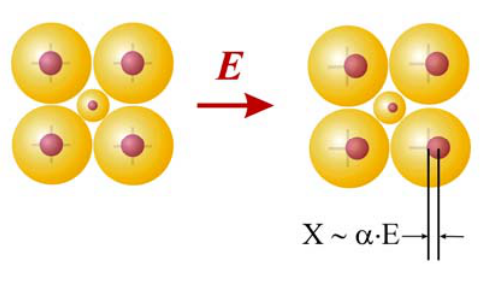
Figure 4 The shift of the nuclei relative to the electron clouds by an external electric field E (image from [38], reproduced by permission of The Royal Society of Chemistry). The radius of the clouds indicates the size of the polarizability. The external field induces a small change in the value of the electronic polarizability volumes, but this effect is neglected. Furthermore, in the hard-spheres approximation, the electronic clouds of different atoms are not free to move relative to each other. In a classical picture at optical frequencies, the atom’s nucleus is the center of the light-wave induced vibration of the